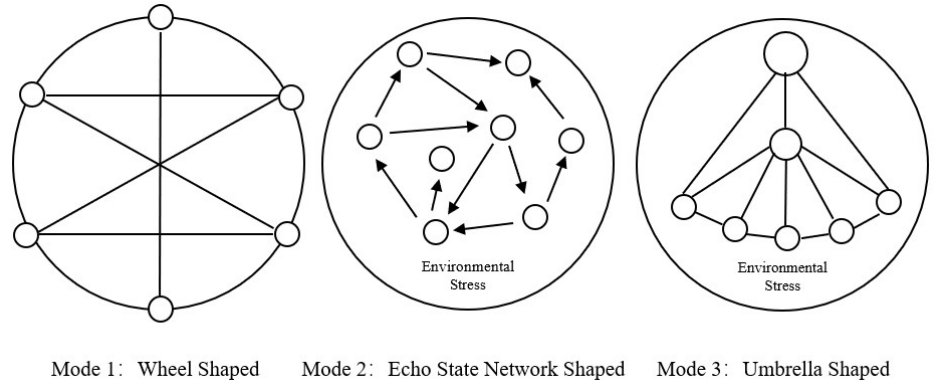
Figure 2. Three modes facilitating medium–high intensity collaborative governance relationships. Note: “ ○ ” represents the actors participating in the coastal zone environmental governance; “ ─ ” represents the establishment of a medium–high intensity collaborative governance relationship among actors; and “ → ” represents the initialization stage of the establishment of medium–high intensity collaborative governance relationship, where the direction of the arrow represents the direction of the randomly generated connection relationship.